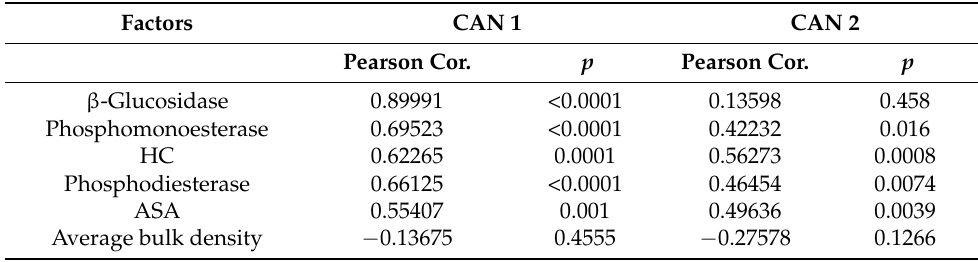
Table A2. Pearson correlation